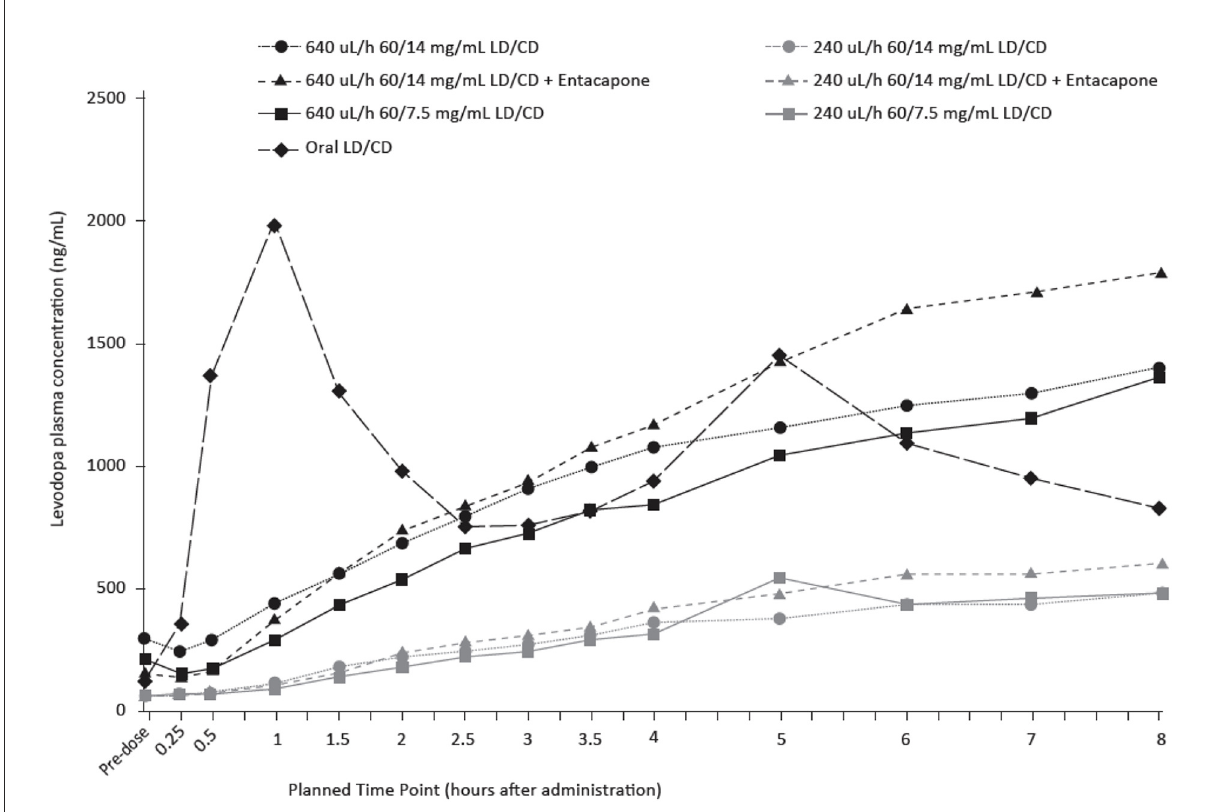
FIGURE4 Mean plasma levodopa levels following continuous SC administration of ND0612 over 8h with varying rates and carbidopa